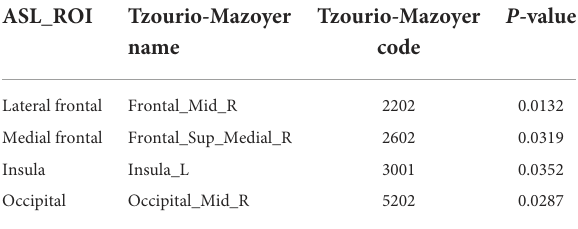
TABLE 4 The key brain nodes with significantly different Deg. TABLE 5 The key brain nodes with significantly different